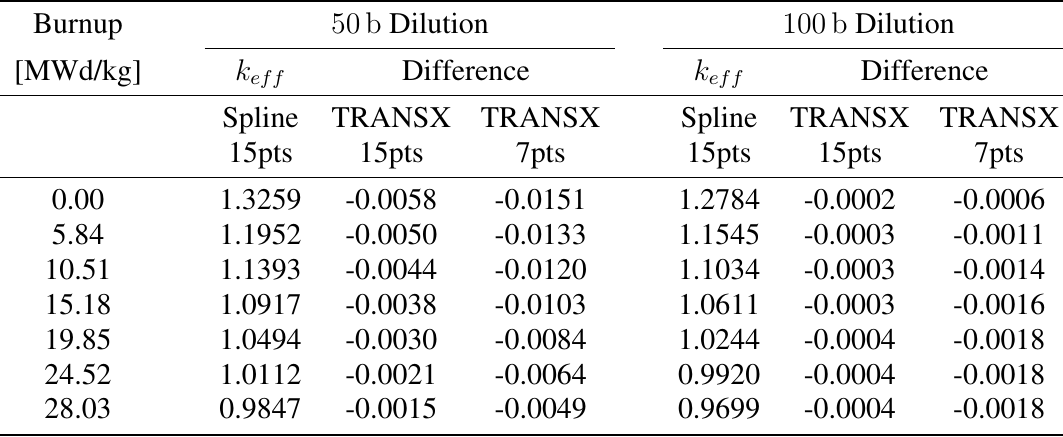
Table 2: Comparison of eigenvalues of the VERA pin-cell problem with depletion. The 50 b results are characteristic of the pin-cell, but have an exaggerated error due to the location of base-points in the dilution grids. The 100 b results show much smaller errors due to the grids containing a base point near the adjusted U-238